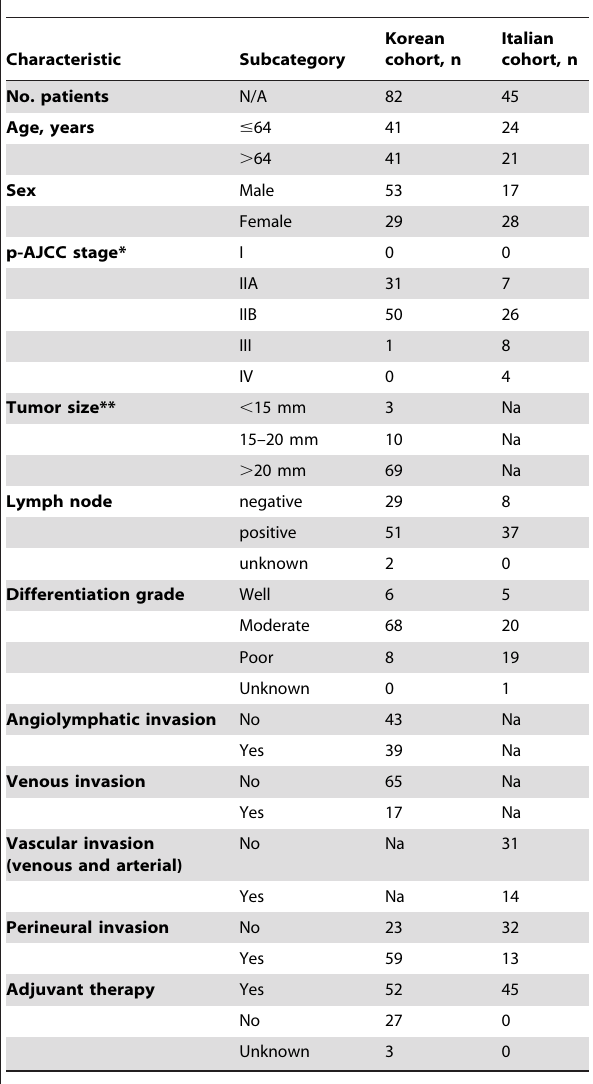
Table 1. Clinical characteristics of pancreatic ductal adenocarcinoma (PDAC)